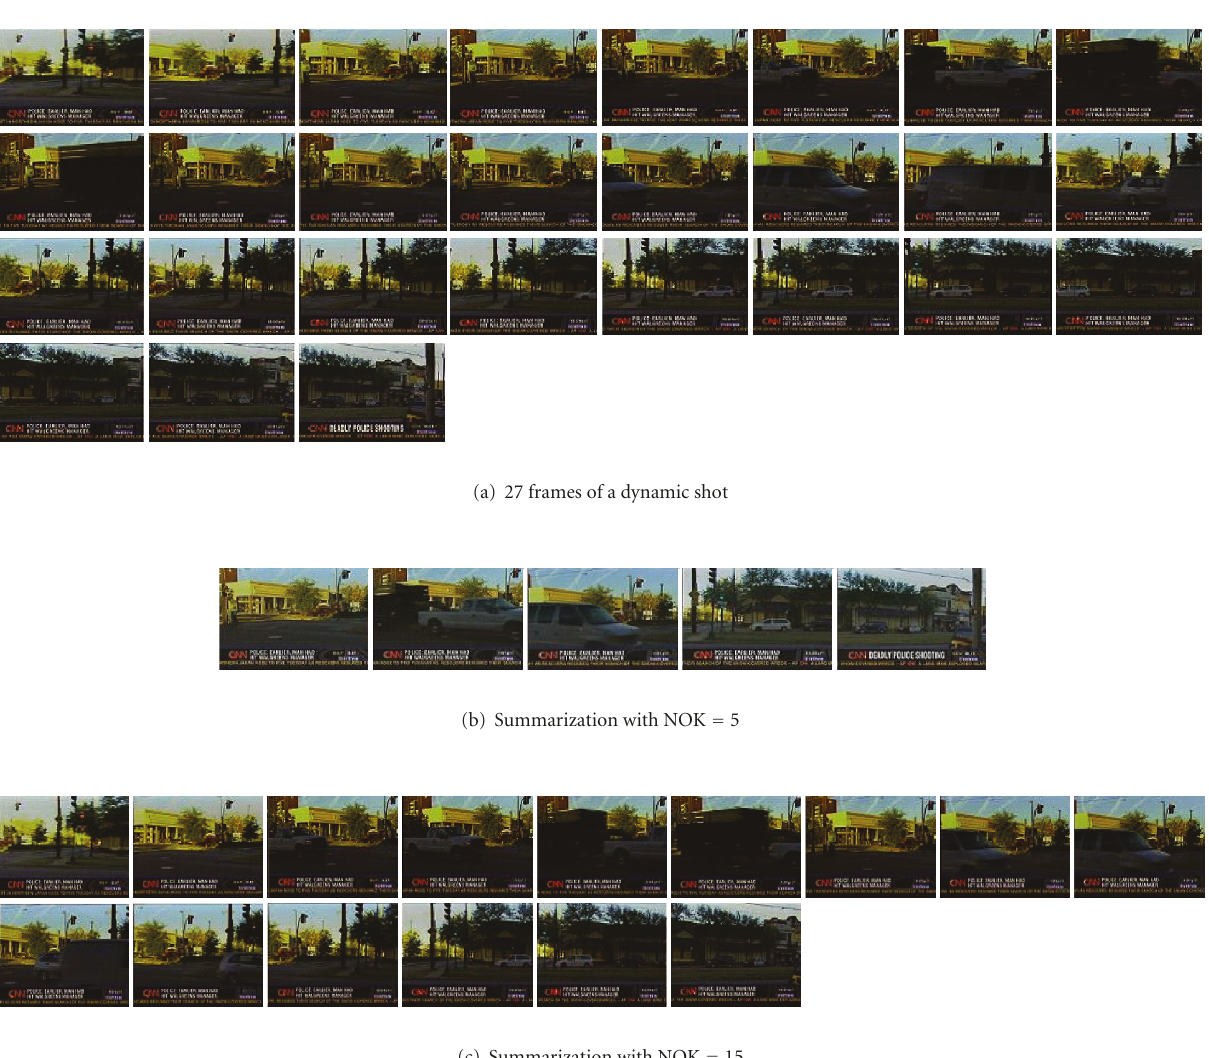
Figure 5: Some of the frames of a dynamic shot which has been summarized with 5 and 15 keyframes.